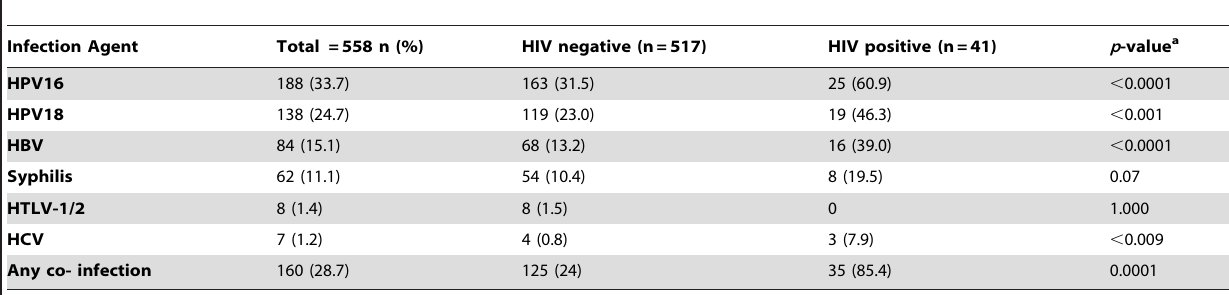
Table 5. Co-infections between HIV positive and negative